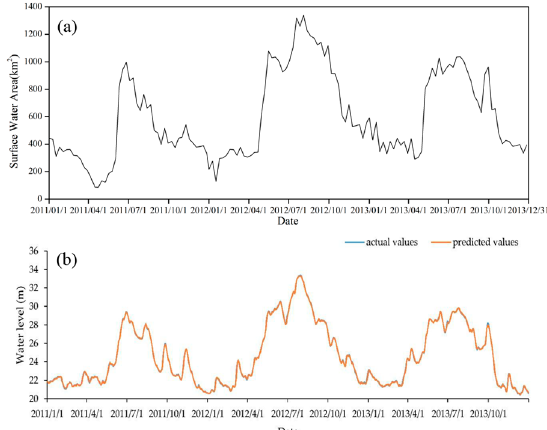
Figure 10. ( a ) Areal changes of Dongting Lake water area from 2011 to 2013; ( b ) water level of Dongting Lake from 2011 to 2013 [51]. Lake from 2011 to 2013